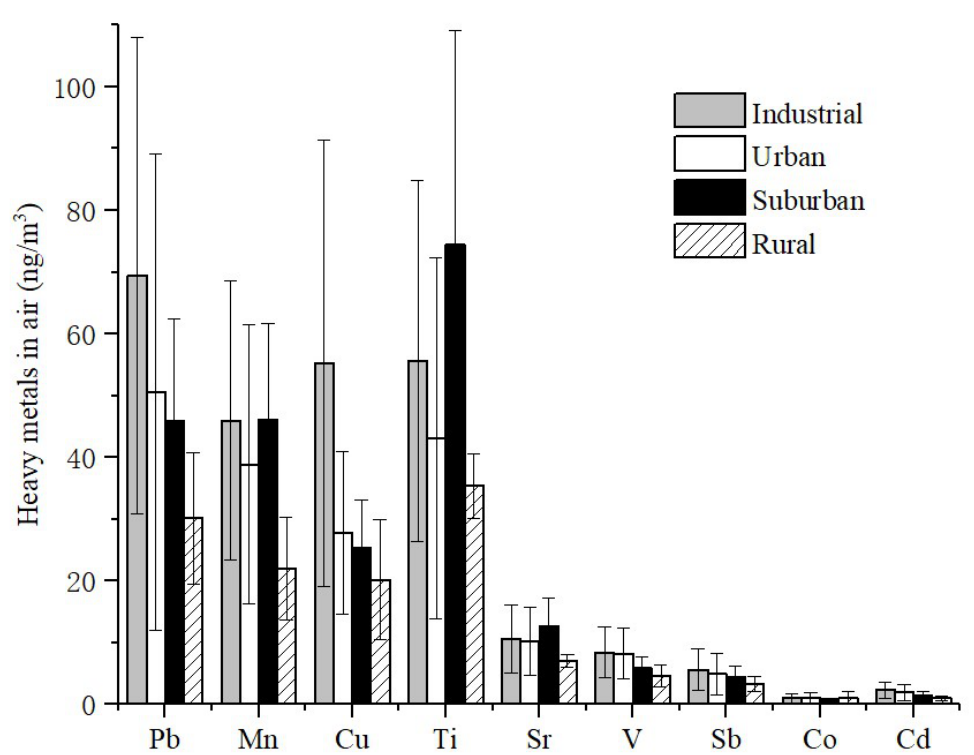
Figure 5. Comparison of the concentrations of PM 2.5 -bound heavy metals (ng/m 3 ) in air among four different functional regions in Nanjing city during 2016.